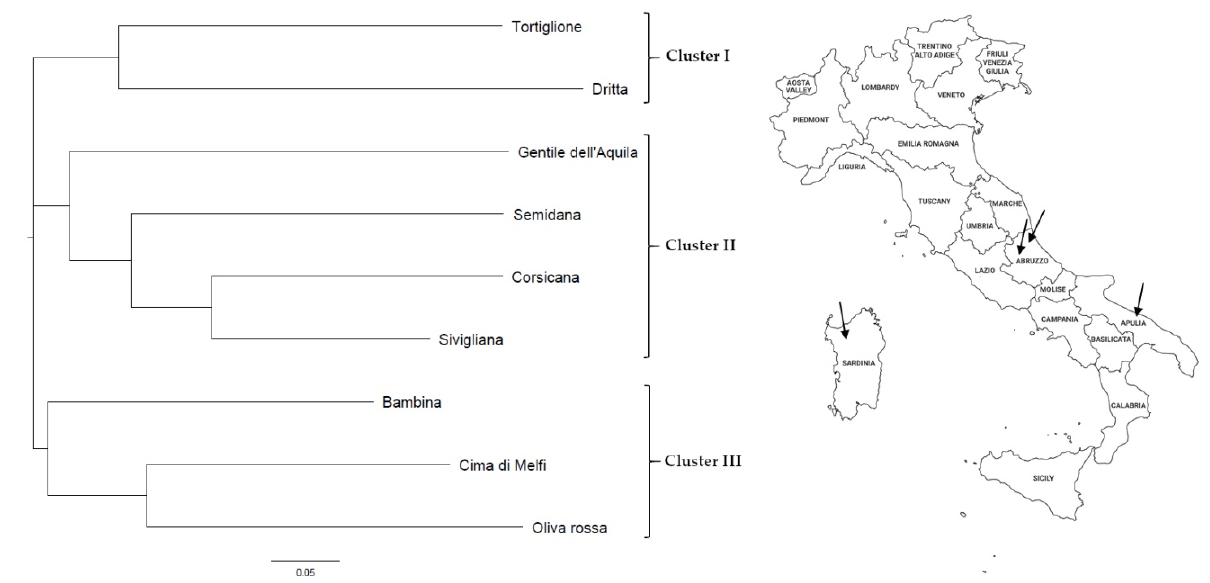
Figure 1. Unweighted Neighbor Joining dendrogram illustrating the clusterization of the olive cultivars under study, and a map of Italy with indication of the considered regions and the corresponding drupe sampling sites.